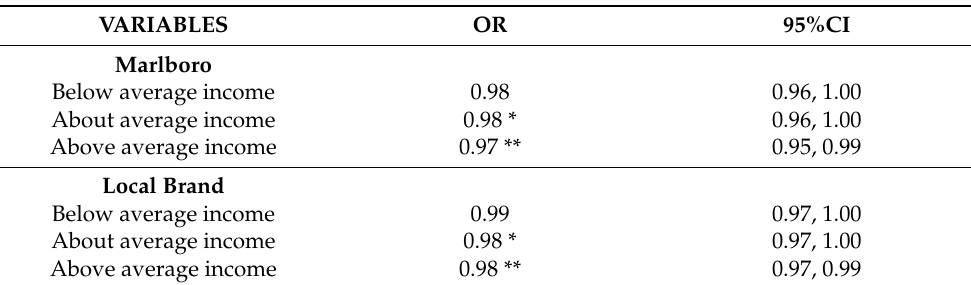
Table 3. Cigarette Prices a and Smoking Prevalence Stratified by Household Income b : KAP 2002– 2017: Logistic Regression c .